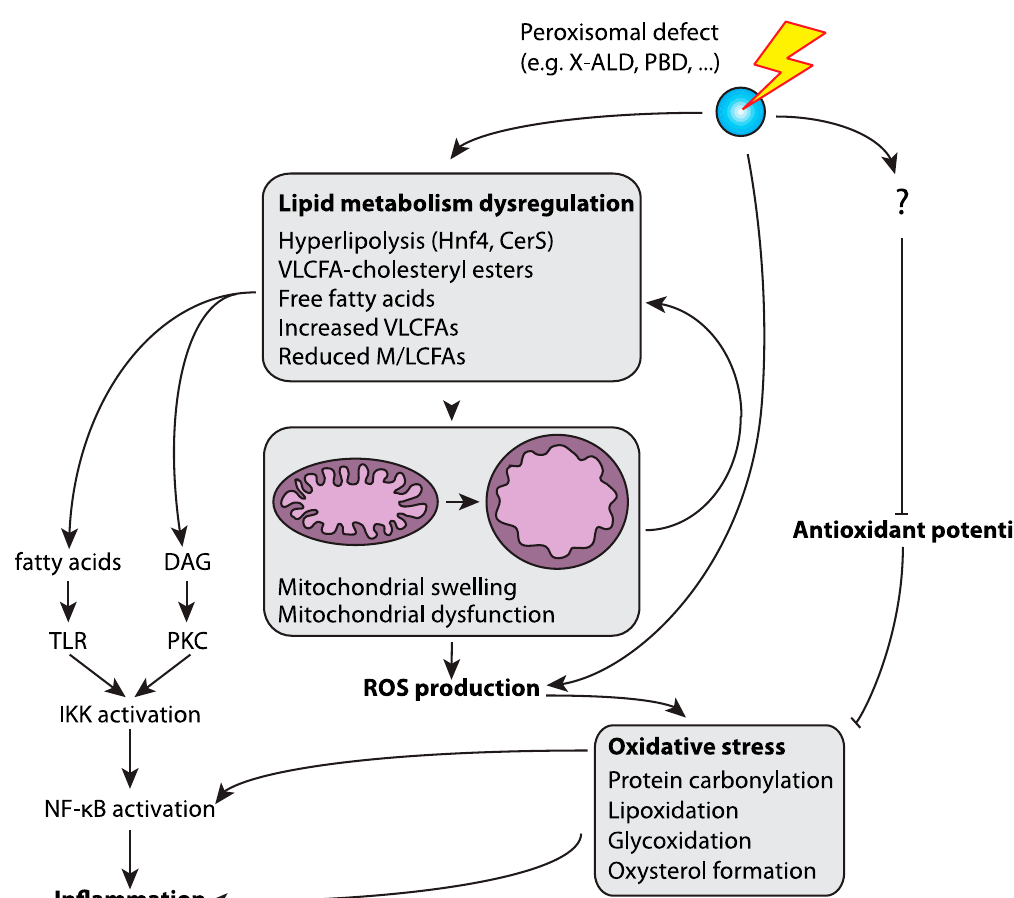
Figure 2. Peroxisomes, oxidative stress and inflammation. Oxidative stress can be the result of increased reactive oxygen species (ROS) production or a decreased antioxidant potential. The defective peroxisomes increase ROS production and reduce the antioxidant ability of the cell. The dysfunctional peroxisomes result also in overall lipid alterations, like the accumulation of VLCFAs and VLCFA-cholesteryl esters. In Drosophila tissue with no functional peroxisomes, the accumulation of free fatty acids was observed. These lipid metabolic defects contribute to mitochondrial damage and swelling, leading to increased ROS production which in turn causes protein carbonylation, lipoxidation, glycoxidation and oxysterol formation, inducing stress pathways and inflammation. Lipid metabolic dysregulation in mammalian systems also causes inflammation via the induction of Toll like receptor (TLR) and Protein kinase C (PKC)-mediated NF- κ B signaling.